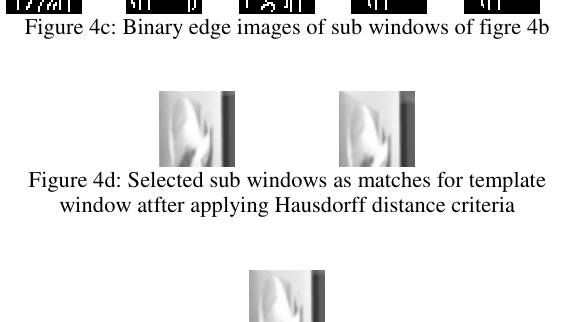
Figure 4c: Binary edge images of sub windows of figre 4b